Question: What style of plot is this figure drawn as?
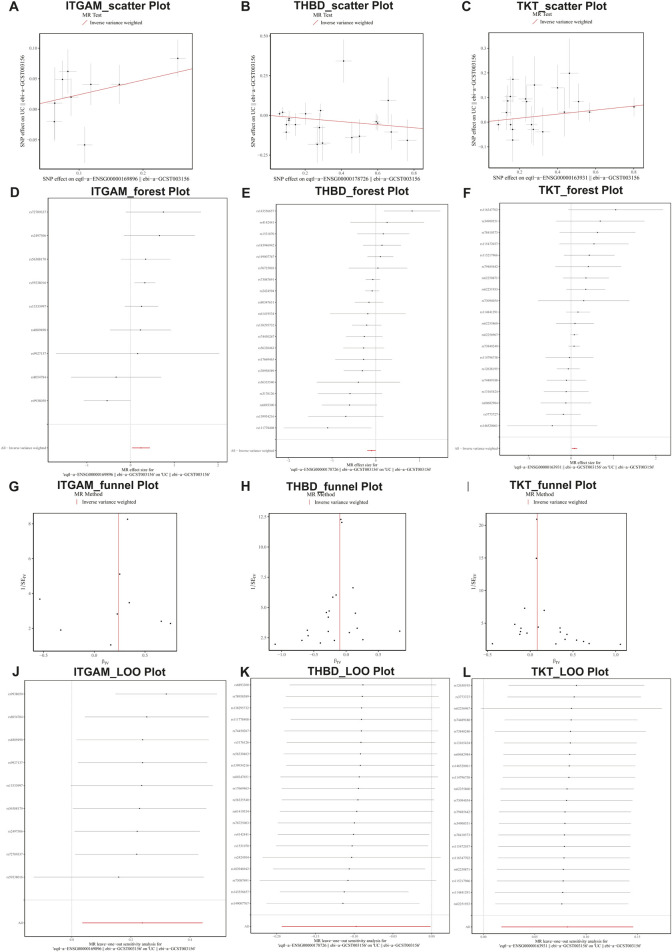
Answer: forest